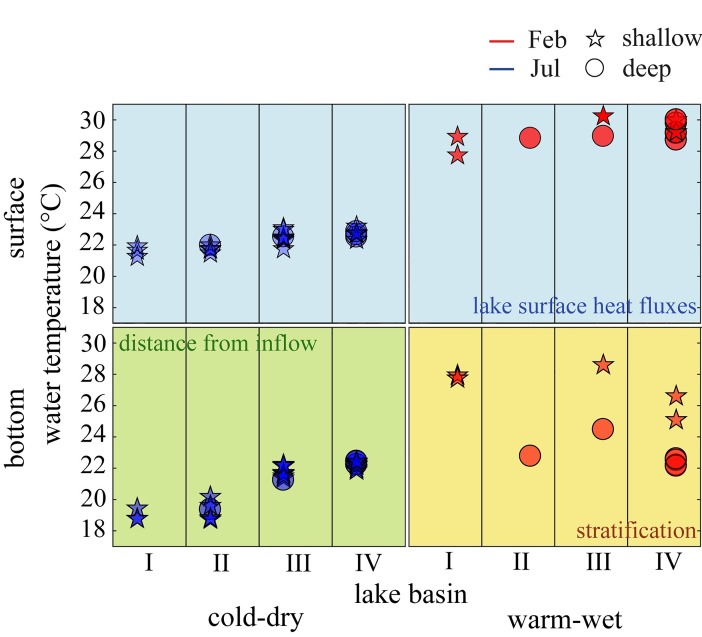
Spatio-temporal analysis of water temperature in Lake Kariba.Stars and circles represent locations where the lake is shallower and deeper than 50 m, respectively. Background colours highlight the different drivers of the lake water temperature.